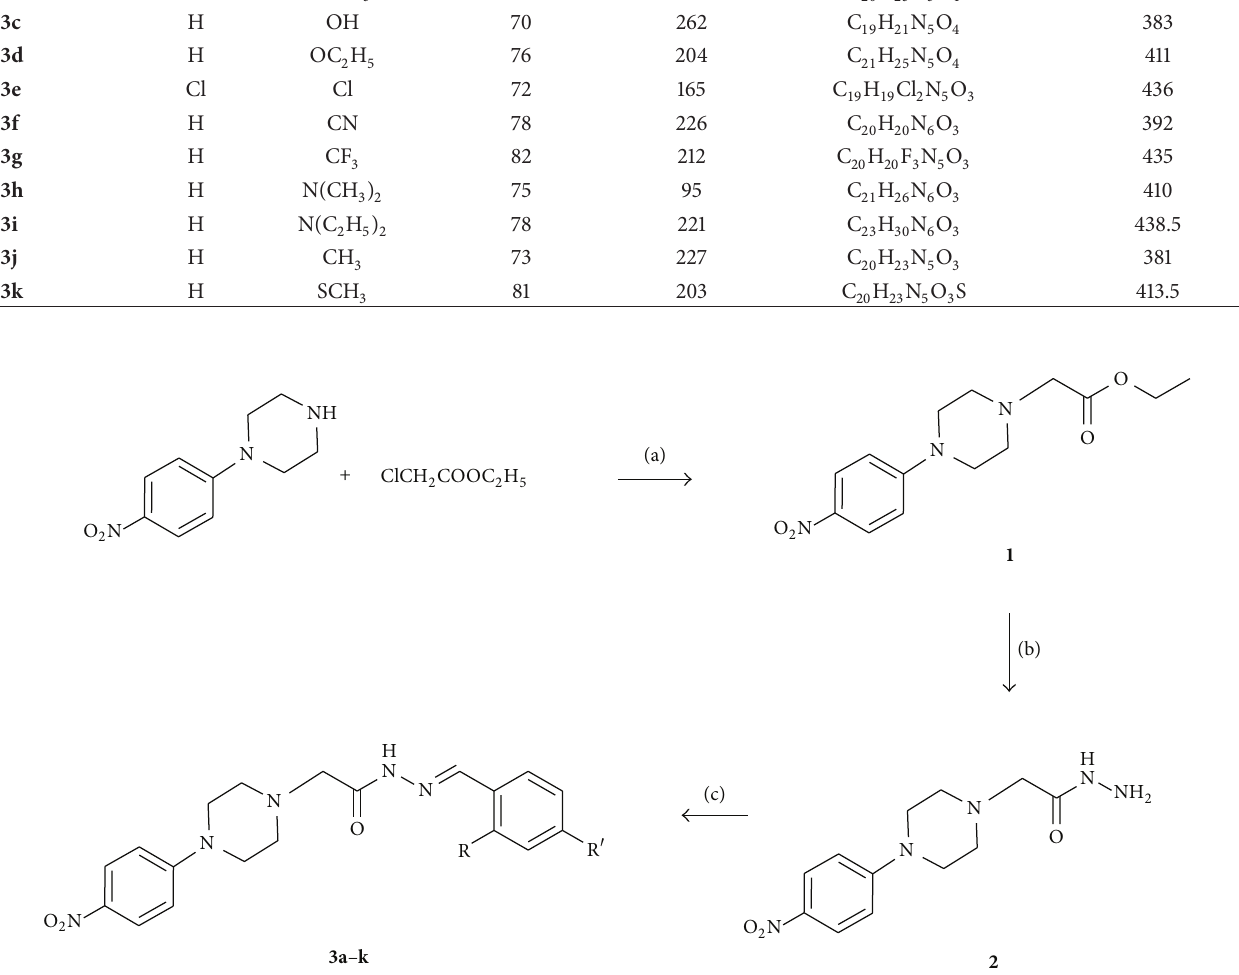
Figure 1: Synthesis of the compounds ( 3a – k ). Reactants, reagents, and conditions; (a) K 2 CO 3 , acetone rt; (b) NH 2 NH 2 ⋅ H 2 O, ethanol, rt; (c) aromatic aldehyde, ethanol,